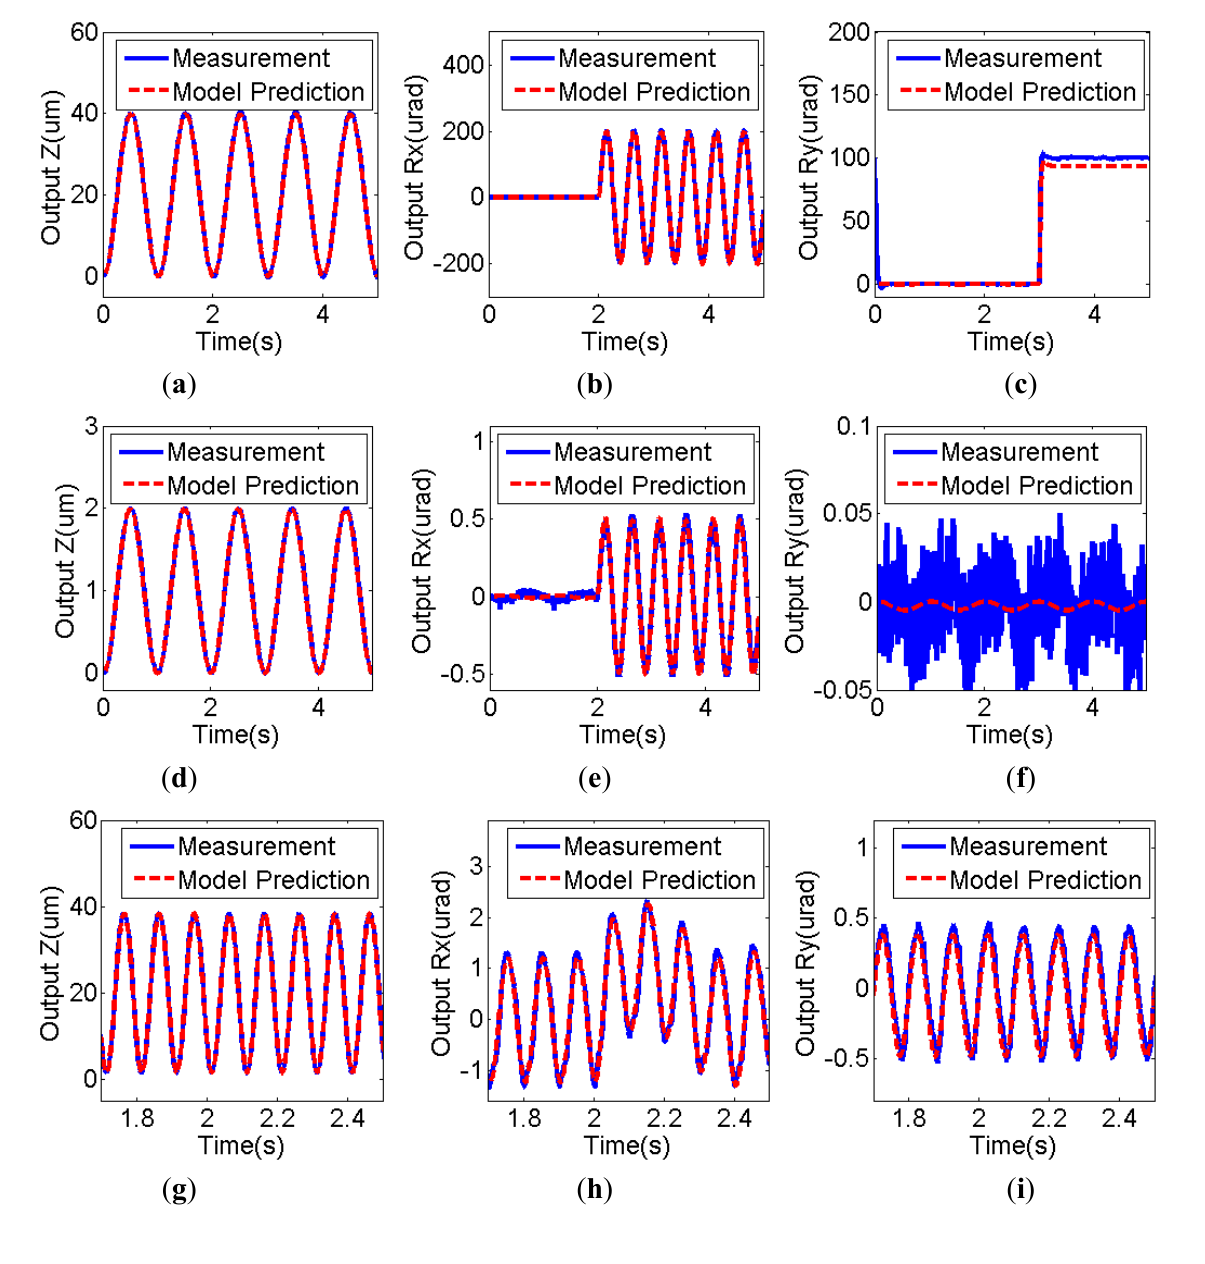
Figure 6. Comparison of experimental results and model prediction from combined inputs to all three channels in the first experiment ( a–c ); in the second experiments ( d–f ) and in the third experiments ( g–i